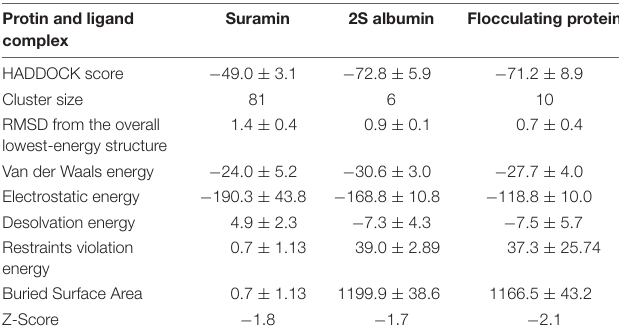
Frontiers in Molecular Biosciences |